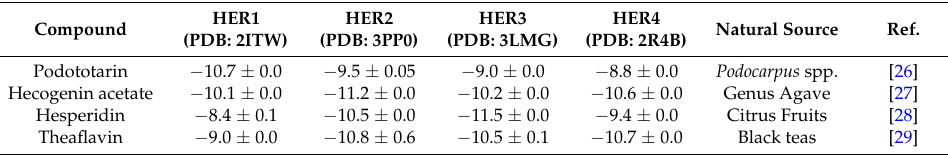
Table 1. AutoDock Vina-calculated affinities (kcal/mol) for virtual hits compound as potential HER